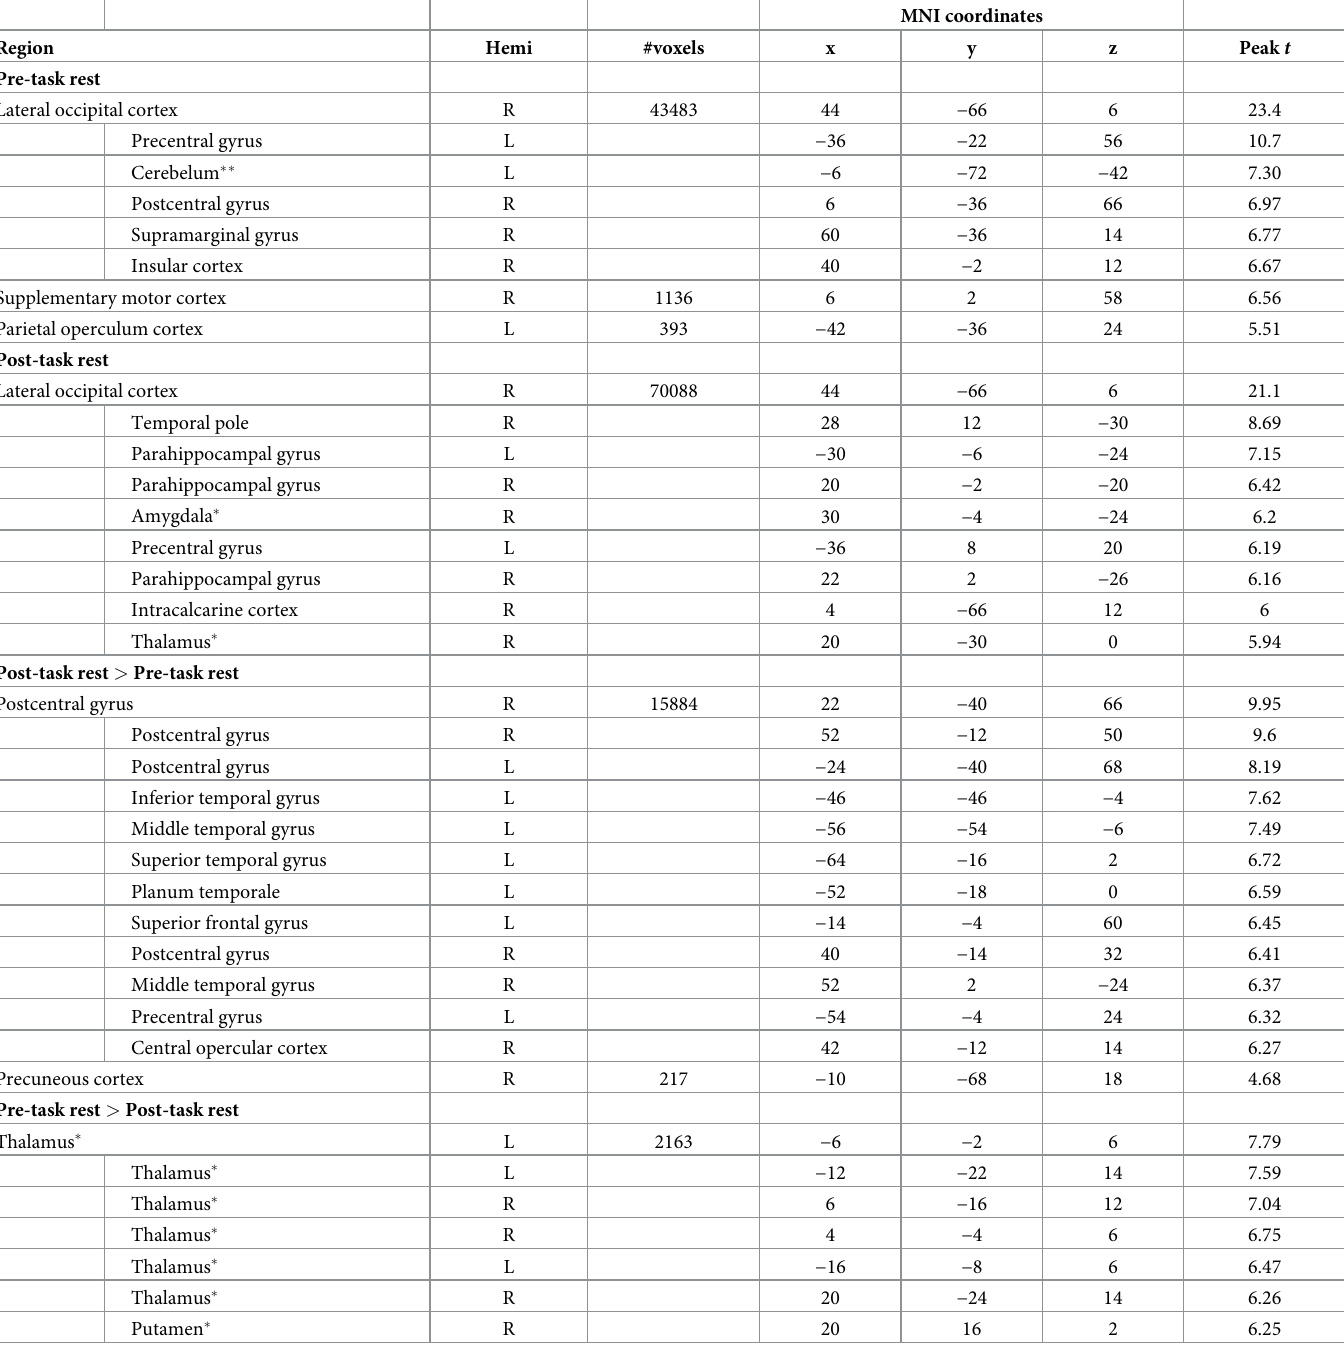
Anatomical labels derived from Harvard-Oxford cortical structural atlas. (cid:3) Labels derived from Harvard-Oxford Subcortical structural atlas. (cid:3)(cid:3) Labels derived from Automated Anatomical Labels. L = left hemisphere, R = right hemisphere, #voxels = number of